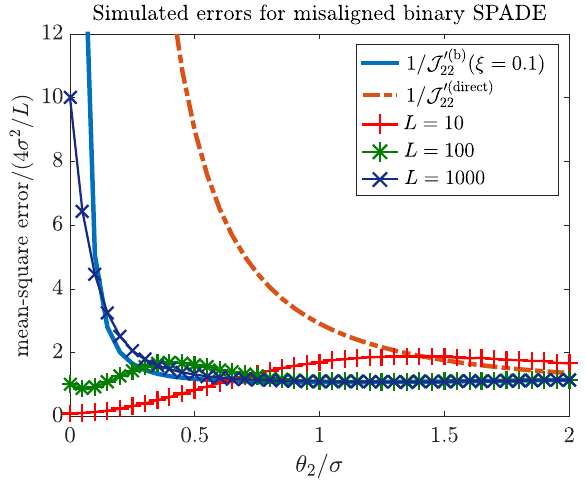
FIG. 16. Simulated mean-square errors of binary SPADE with misalignment level ξ ¼ 0 . 1 , conditioned on L detected photons. The maximum-likelihood estimator that assumes no misalign- ment is used. Note that the vertical axis is normalized with respect to 4 σ 2 =L . Each error is computed by averaging 10 5 simulations, and the lines connecting the data points are guides for the eye. The errors are substantially below the Cramér-Rao bound for direct imaging (dash-dotted